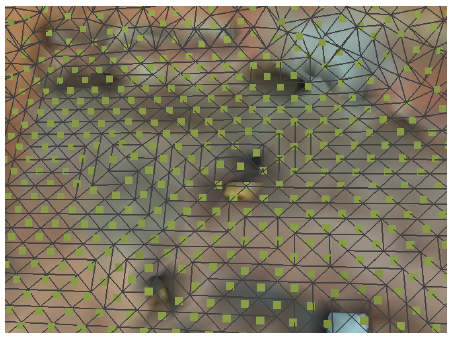
Figure 17. Example of mesh and sampling